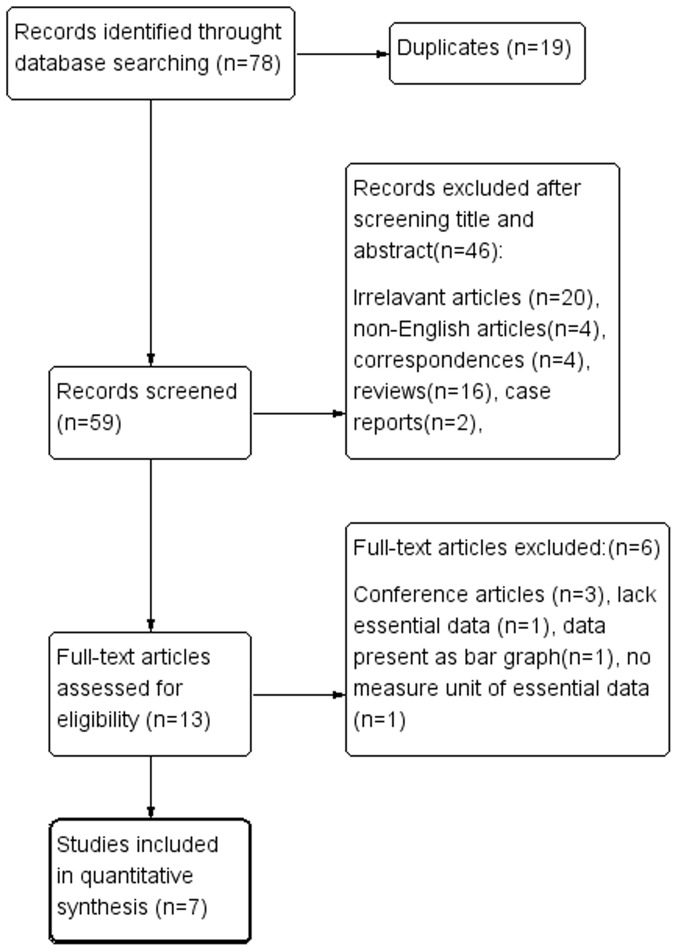
Study flow diagram.